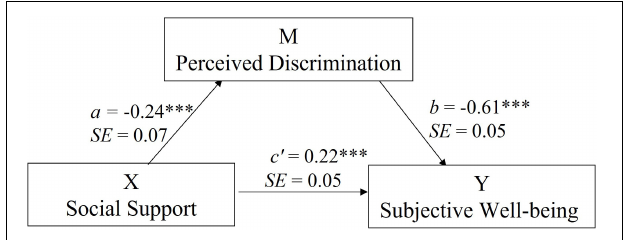
FIGURE 1 | The mediation model for the effect of PD in the relationship between SS and SWB. *** p <